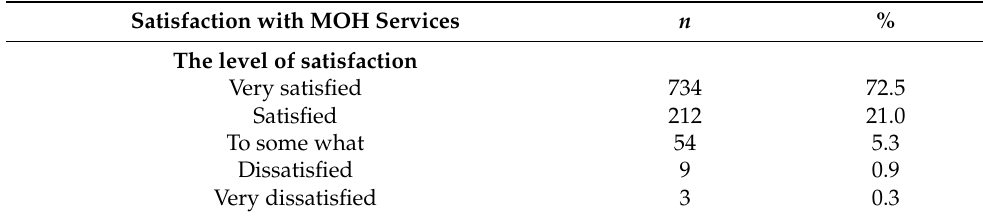
Table 8. Responses to items on level of satisfaction with Saudi Arabia Ministry of Health Services ( n =